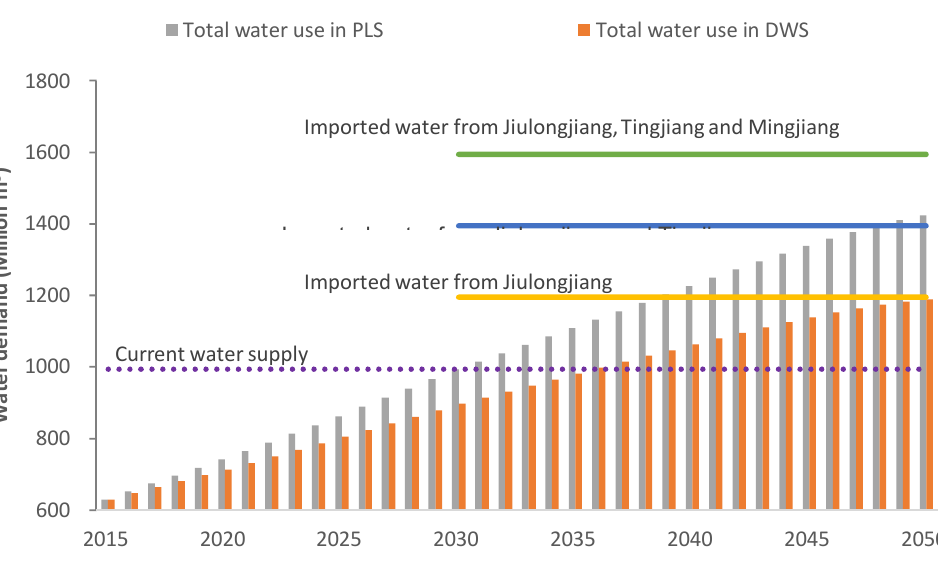
Figure 8. Projected future Xiamen City water supplies and water demand considering only trans-basin water diversion. Note: PLS is the acronym for planning scenario; DWS is the acronym for double water-saving scenario.